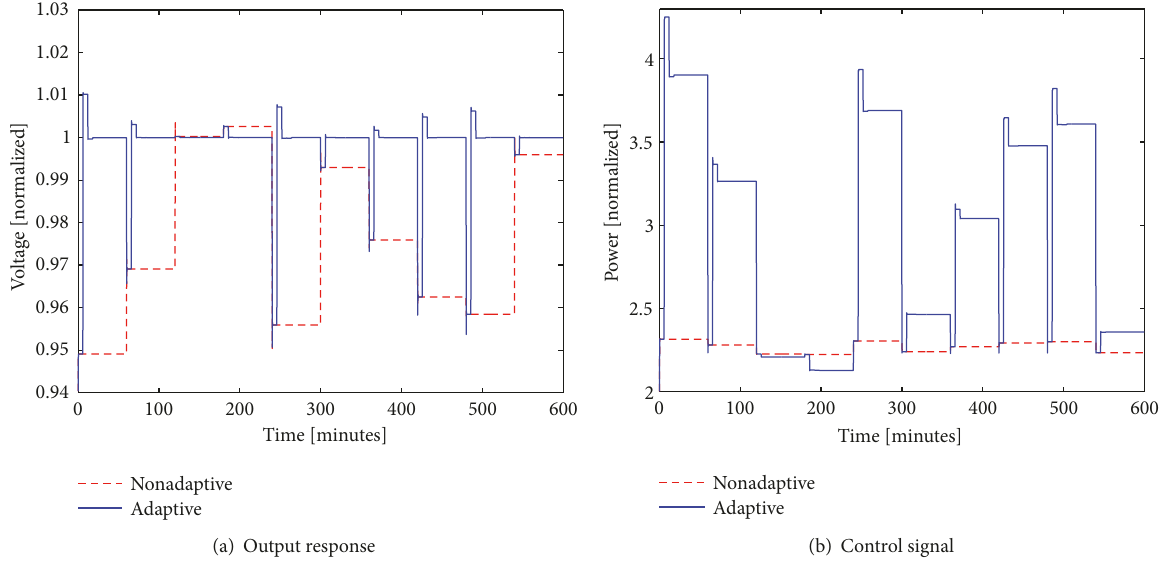
Figure 18: Control system response with and without adaptation process.